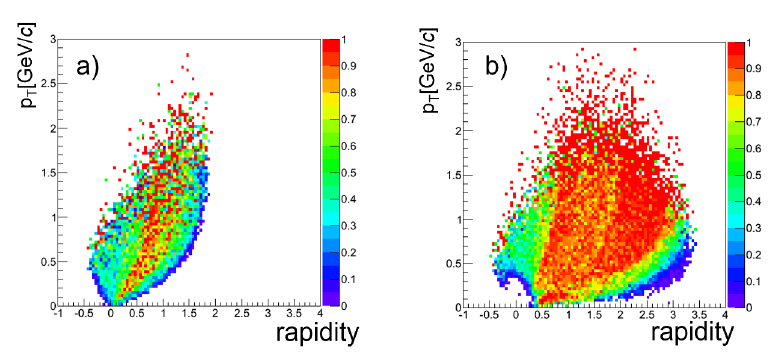
Figure 4. Acceptance of generated protons in heavy ion collisions for the existing spectrometer (a) and upgraded spectrometer